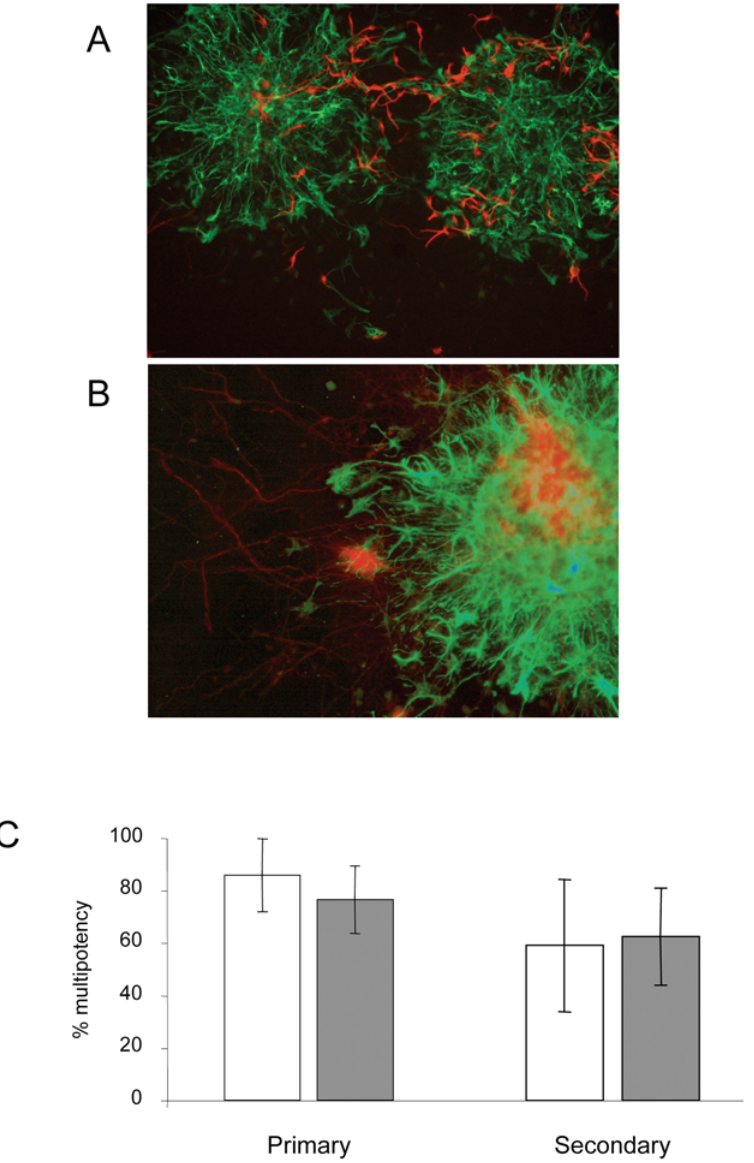
Figure 3. Neurosphere potency. Wild-type (A) or 3KO (B) neurospheres made from E14.5 cortex were differentiated for five days and stained for ß- tubulin III (red) and Gfap (green). C. Proportion of colonies formed staining for both neural (ß-tubulin III) and astrocyte (Gfap) markers when primary or secondary neurosphere cultures were allowed to differentiate. Data for wild-type neurospheres are shown in open boxes; that for 3KO neurospheres is shown in filled boxes. Error bars represent SEM.